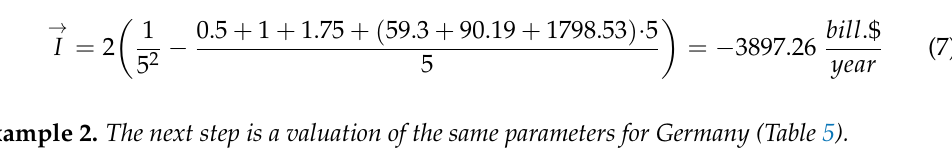
Table 5. Model parameters for